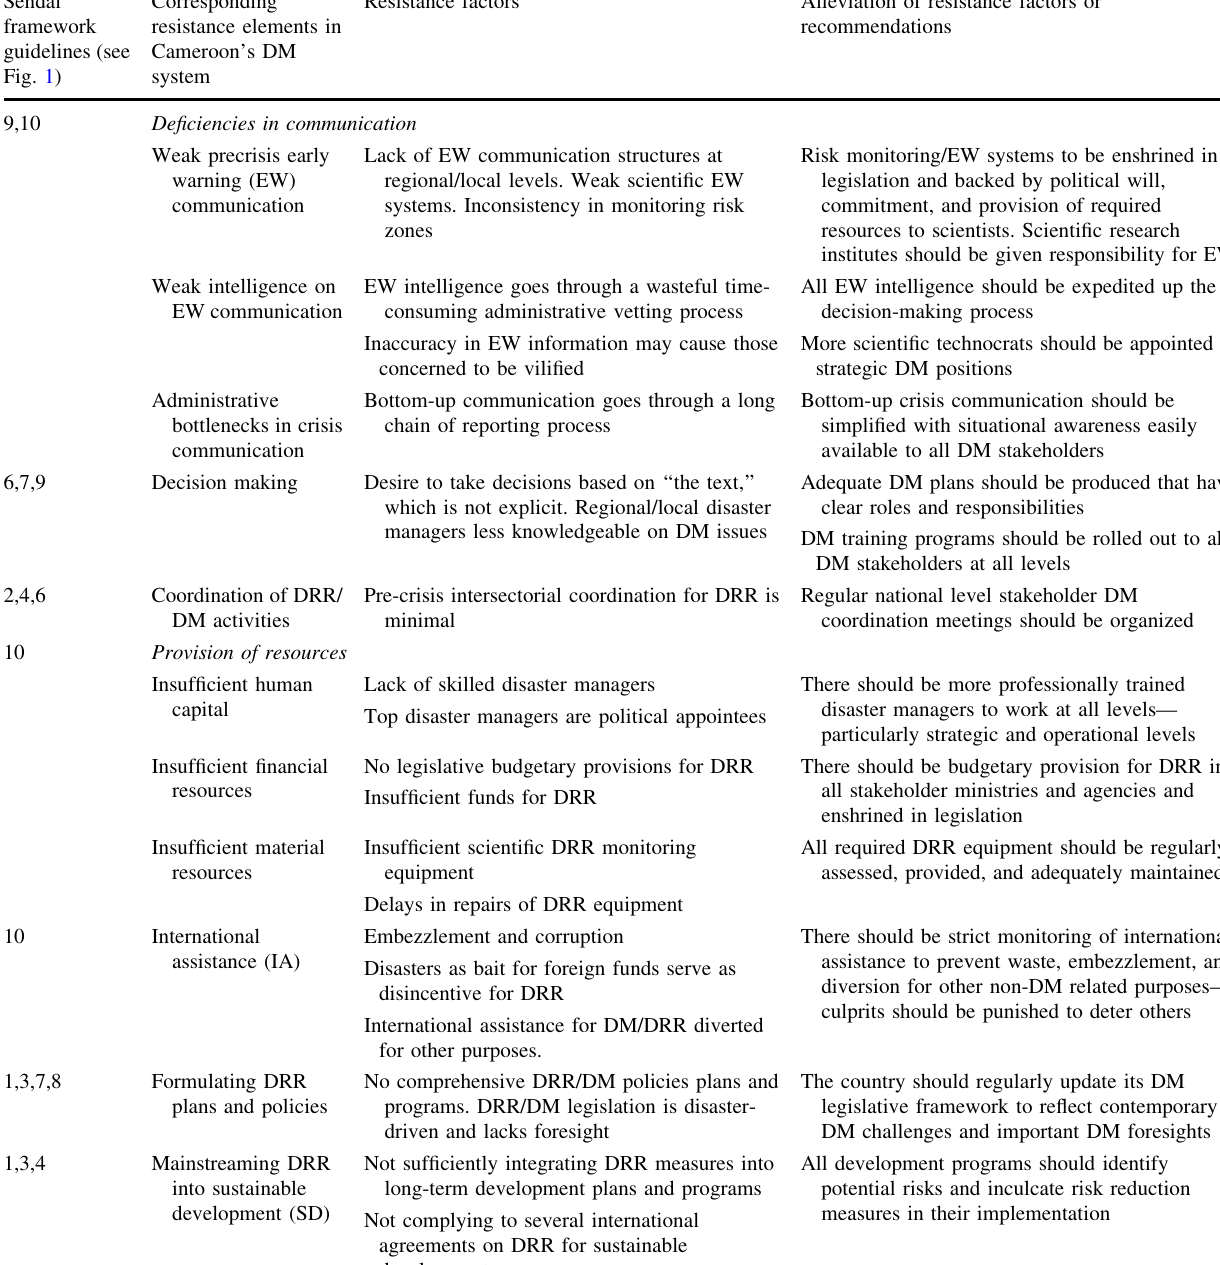
Table 2 Sendai Framework guidelines and their corresponding resistance elements/factors and suggestions for alleviating them Sendai